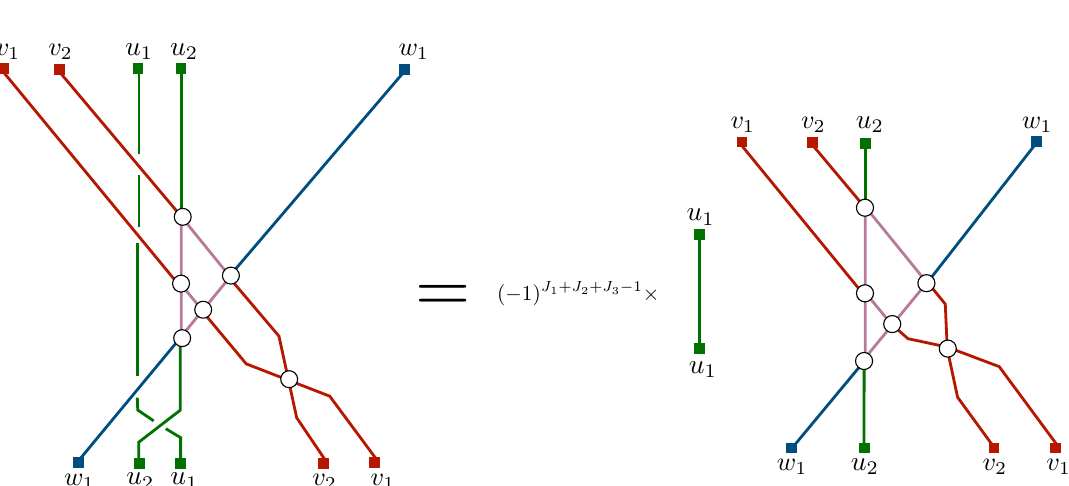
Figure 6 . Decoupling when u 1 → ∞ for Z 2 , 2 , 1 . When one of the rapidities is sent to infinity the vertex reduces to the free S-matrix. All scatterings of particle u resulting in the ( − 1) J 1 + J 2 + J 3 − 1 factor of equation